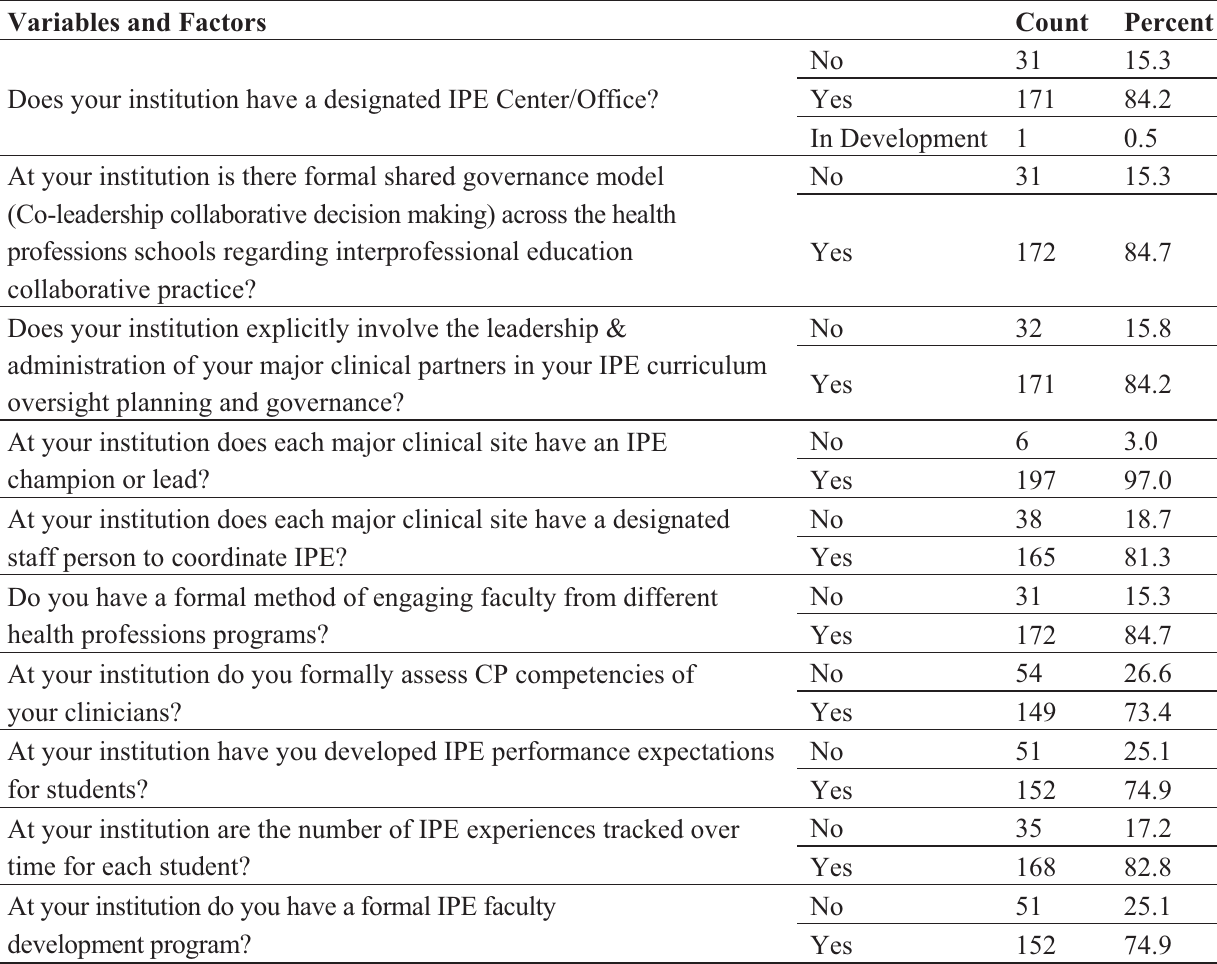
Table 4. Preliminary descriptive analysis of education survey NCDR data (linked to network user survey responders).